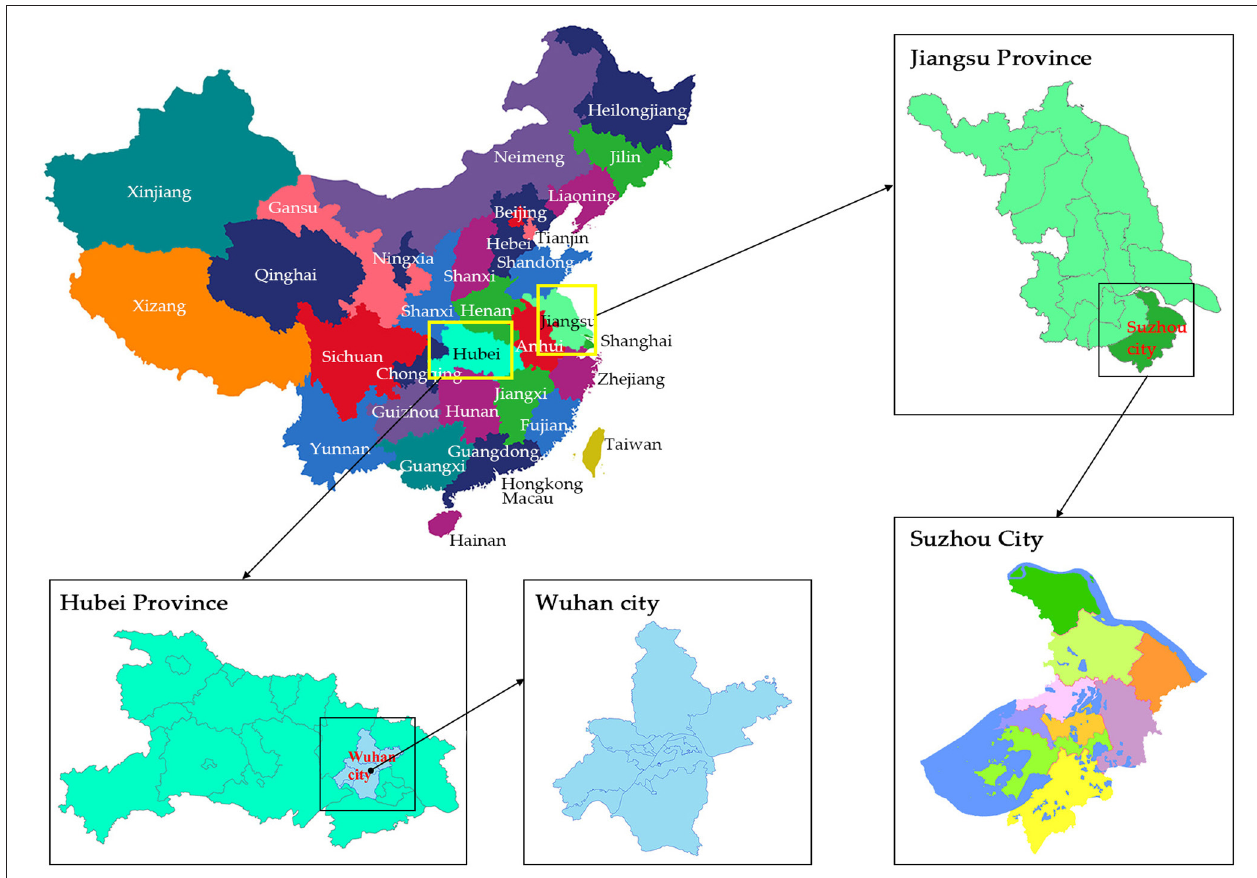
FIGURE 4 | Bootstrapping results with inner model t -values.